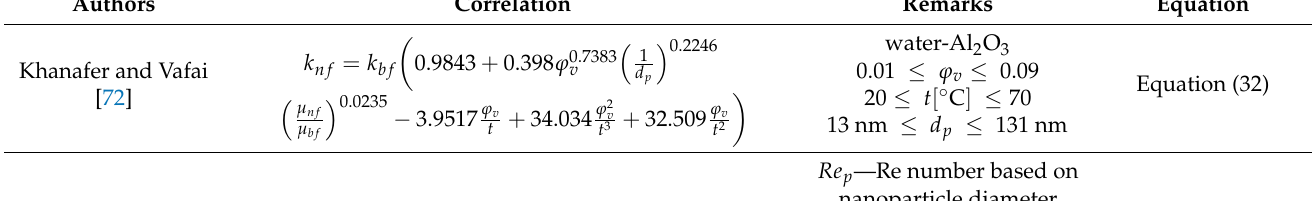
2 O 3 nanofluids.